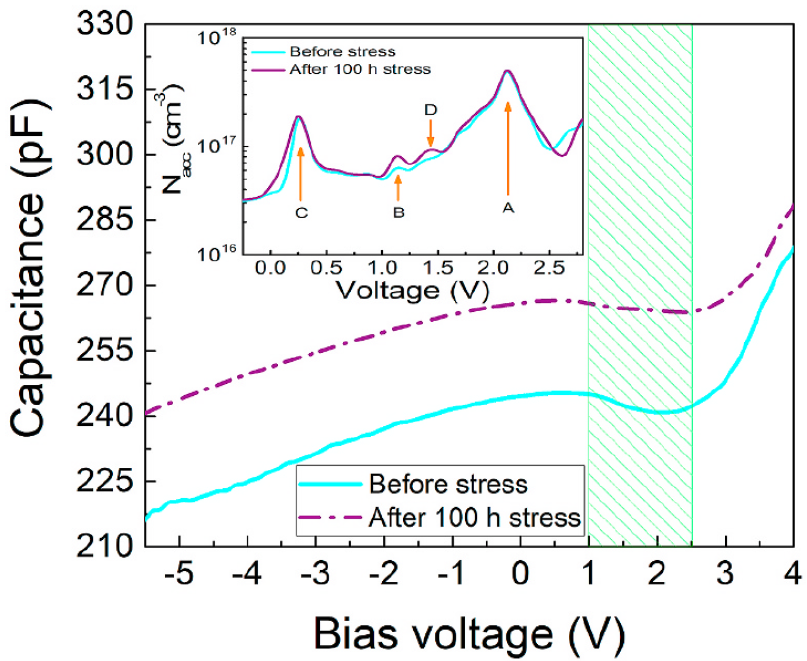
Figure 19. Typical C-V curves of the investigated DUV LED measured before and after stress treatment. Inset: [75]. Copyright 2020, Elsevier.